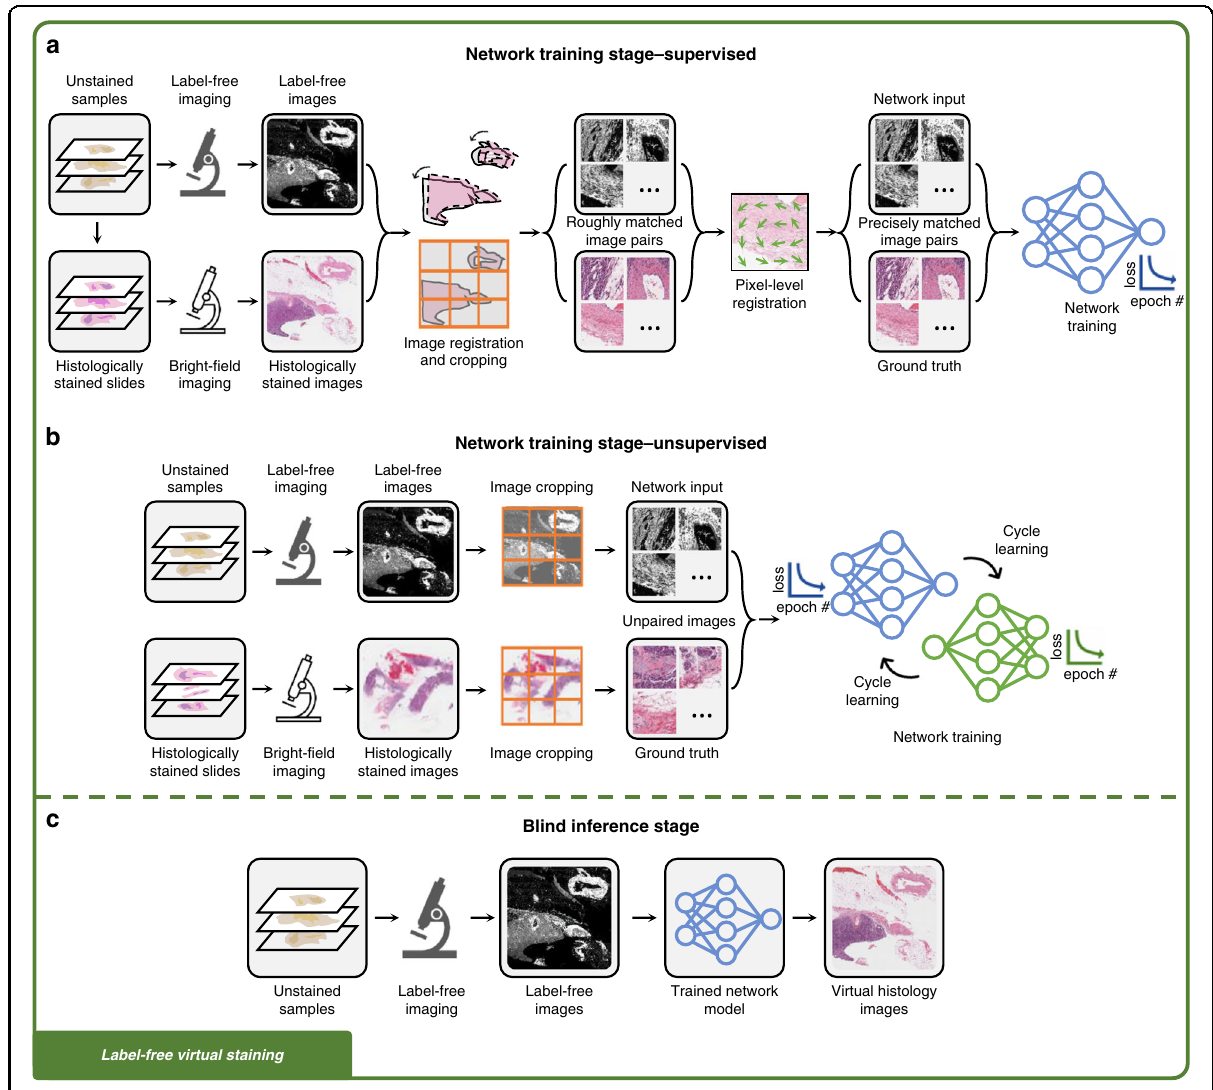
Fig. 2 Training and inference of label-free virtual staining networks. a Training of a label-free virtual staining network using the supervised scheme. Precisely matched input and ground truth image pairs are required, which can be obtained through a multi-stage image registration process. b Training of a label-free virtual staining network using the unsupervised scheme, in which input and ground truth images are not necessarily paired. Cycle-consistency-based learning frameworks are typically used. c Blind inference of a trained virtual staining model. The virtual histology images are rapidly generated from label-free images using a digital